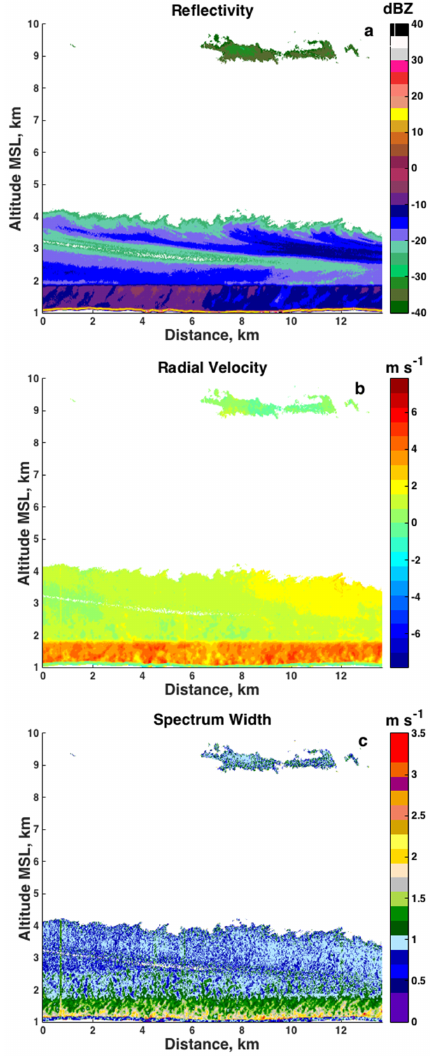
Figure 12. B-scan plots of Ze , V r and spectrum width collected on 11 October 2013 from the HCR looking